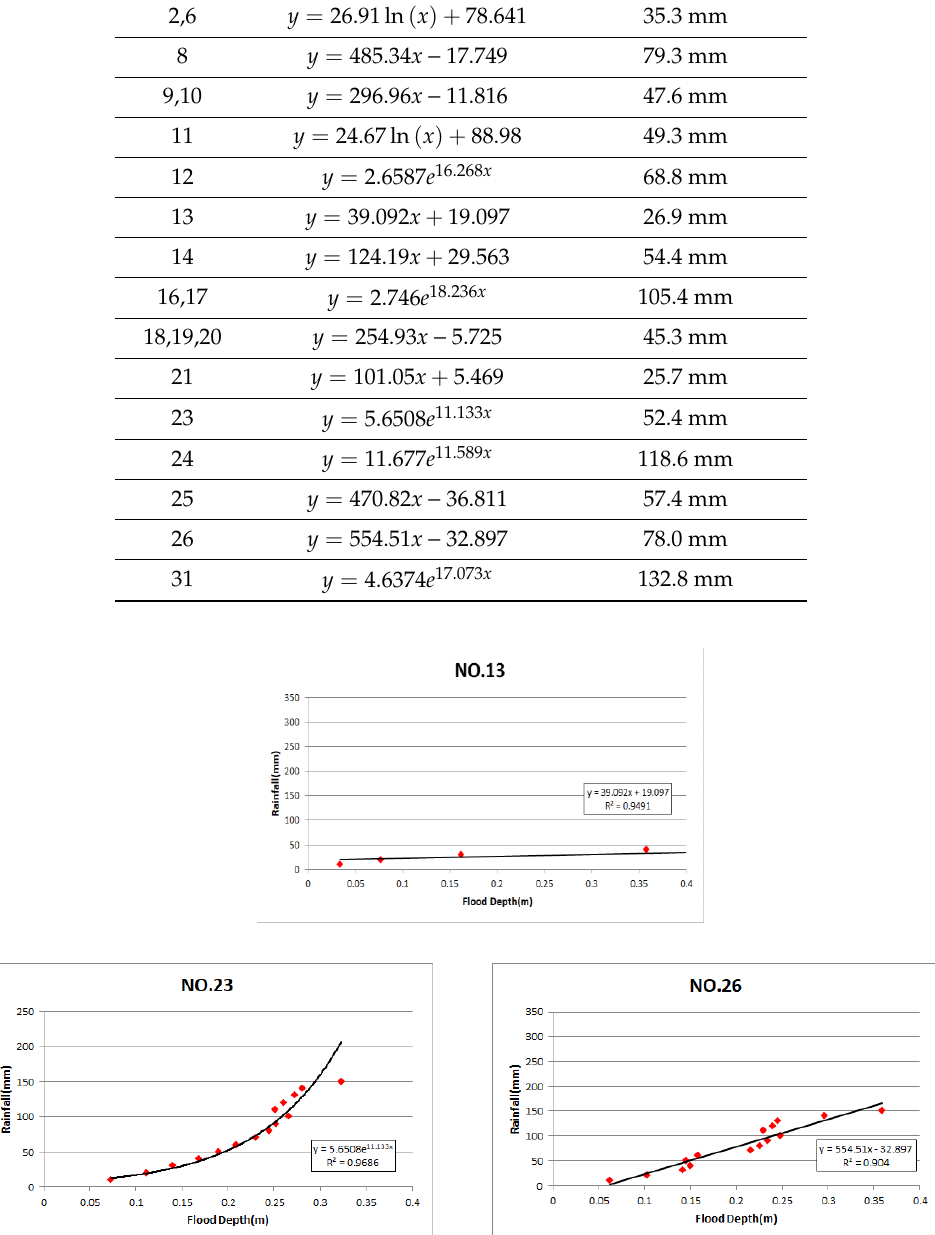
Table 2. Threshold rainfall of each cell.